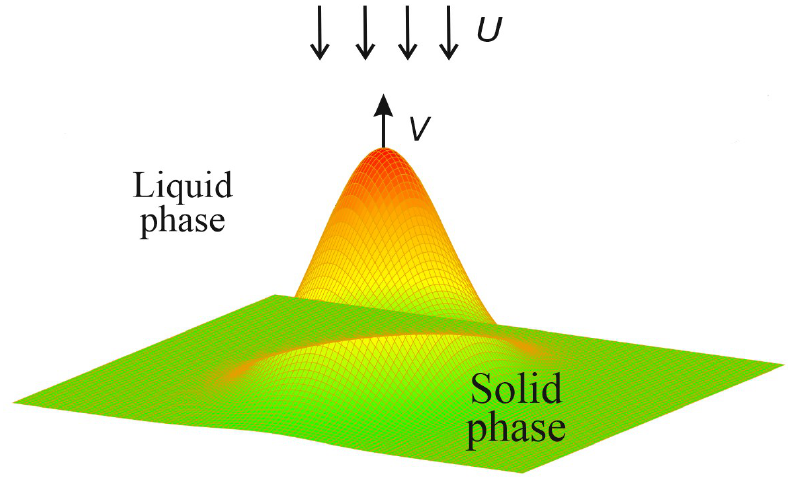
Figure 1. A sketch of the curvilinear solid–liquid